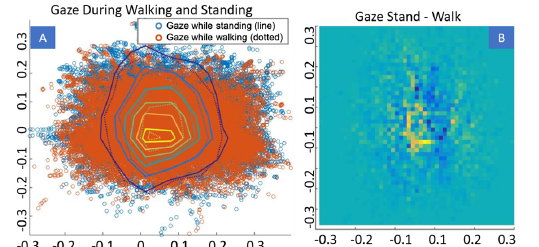
Figure 16: Gaze during walking compared to gaze during stand- ing. (A) Scatterplot of the two gaze classes (Orange - walking, Blue - standing). (B) Heat map of (gazes while standing) – (gazes while